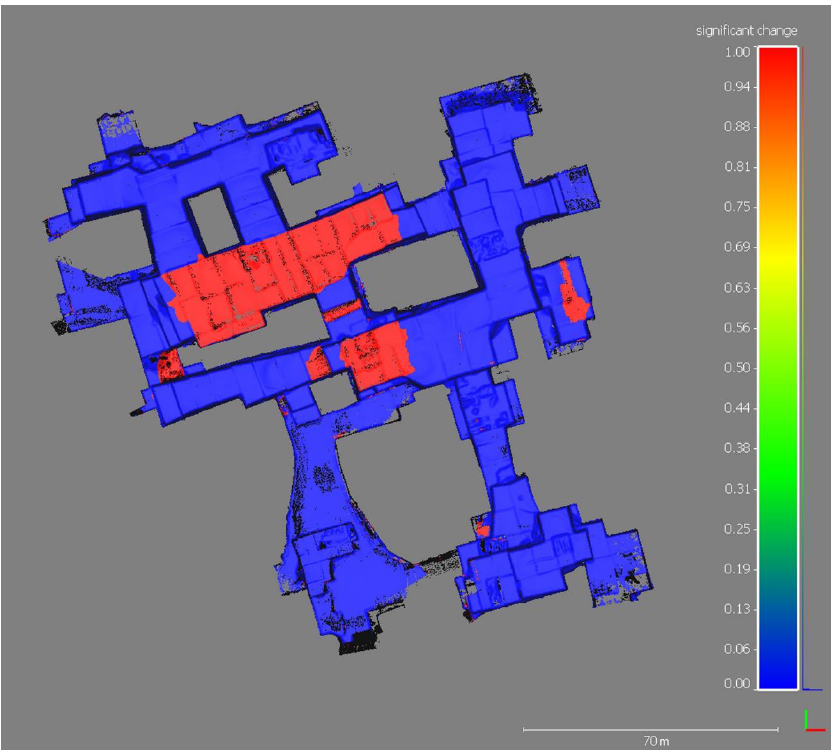
Figure 6. Map of significant changes. Red values, equal to 1, indicate areas of significant variations Figure 6 contrary to blue values, equal to 0, that represent no-change.